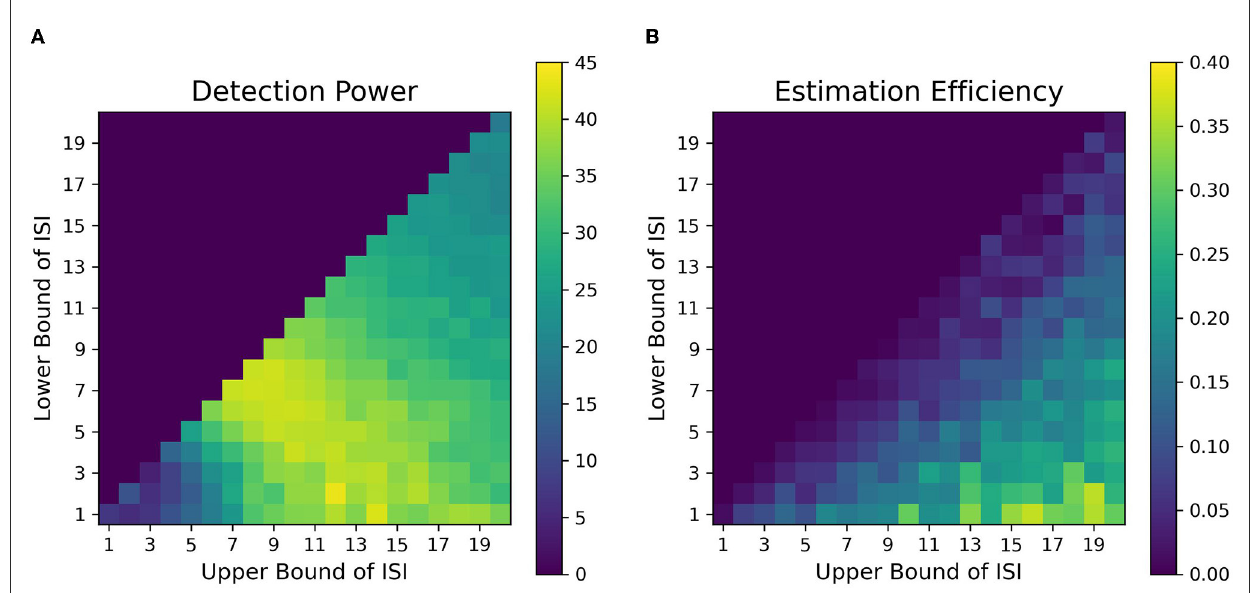
FIGURE7 Fitness landscapes for Simulation 1– Attention . Each pixel in the landscape represents the corresponding measure of optimality as a function of lower and upper bounds of ISI for attentional control transient profiles (TTP 1-4). (A) Detection power. (B) Estimation Efficiency.